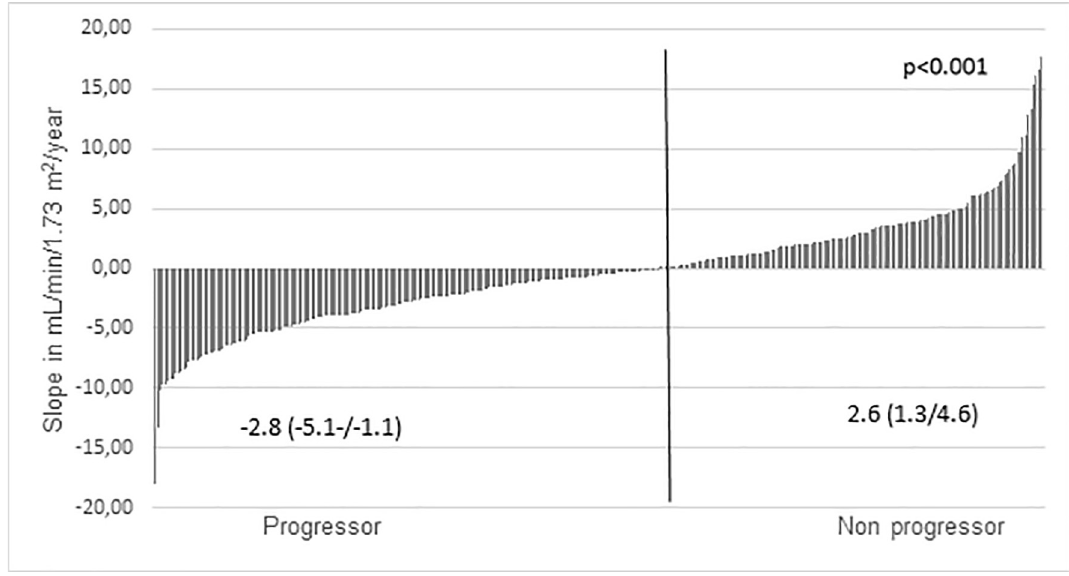
Fig 1. Cohort classification according individual eGFR slope during the study eGFR slope of each patient during the study and cohort classification.